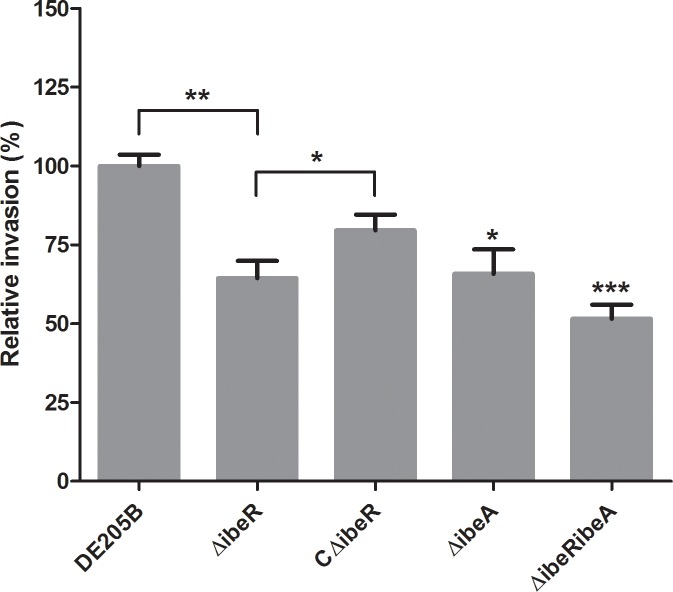
IbeR was involved in invasion DF-1 cells by DE205B.Invasion assays were performed on DF-1 cells. Values are average of three independent experiments. The error bars indicate standard deviations. One-way ANOVA was performed for statistical significance analysis. *** p < 0.001; ** p < 0.01; * p < 0.05.